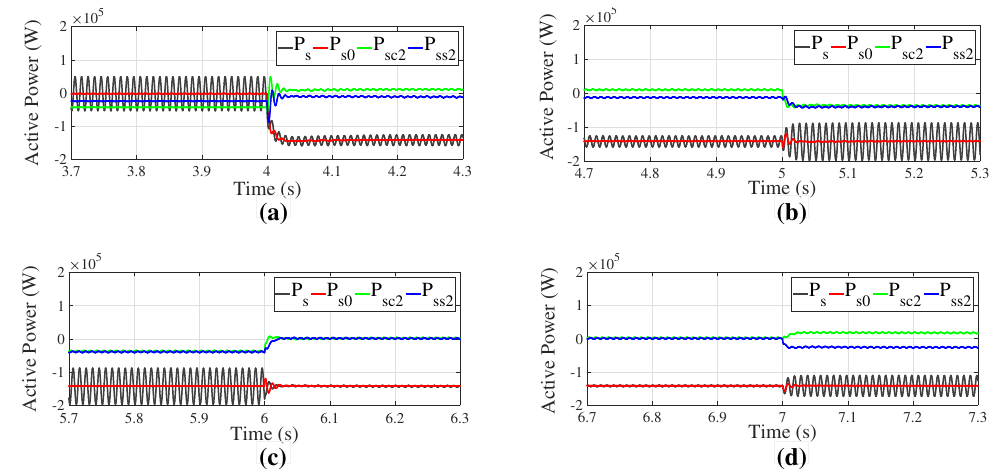
Figure 6. Evolution of the active power (W) when changing from: ( a ) regular control strategy (no compensation to address the voltage imbalance) to Objective I; ( b ) Objective I to Objective II; ( c ) Objective II to Objective III; and ( d ) Objective III to Objective IV.